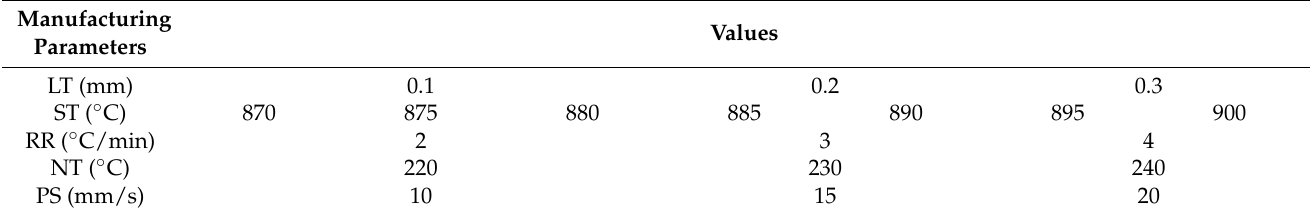
Table 1. Manufacturing